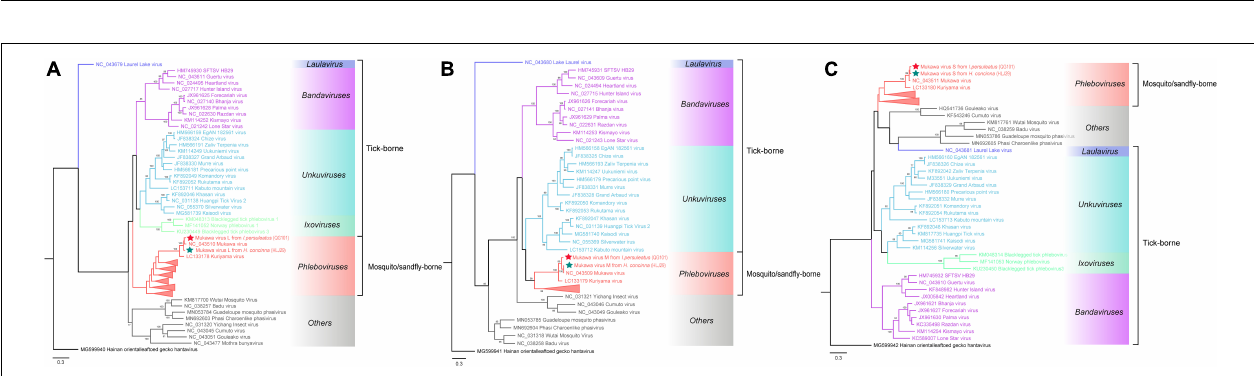
FIGURE 2 | Comparison of homology between MKWV and KURV. Nucleotide and amino acid identities between Japanese MKWV, KURV, and our MKWV from I. persulcatus are marked with red. Nucleotide and amino acid identities’ sequences between Japanese MKWV, KURV, and our MKWV from H. concinna are marked with purple. The nucleotide and amino acid identities of our two MKWVs are marked with blue.